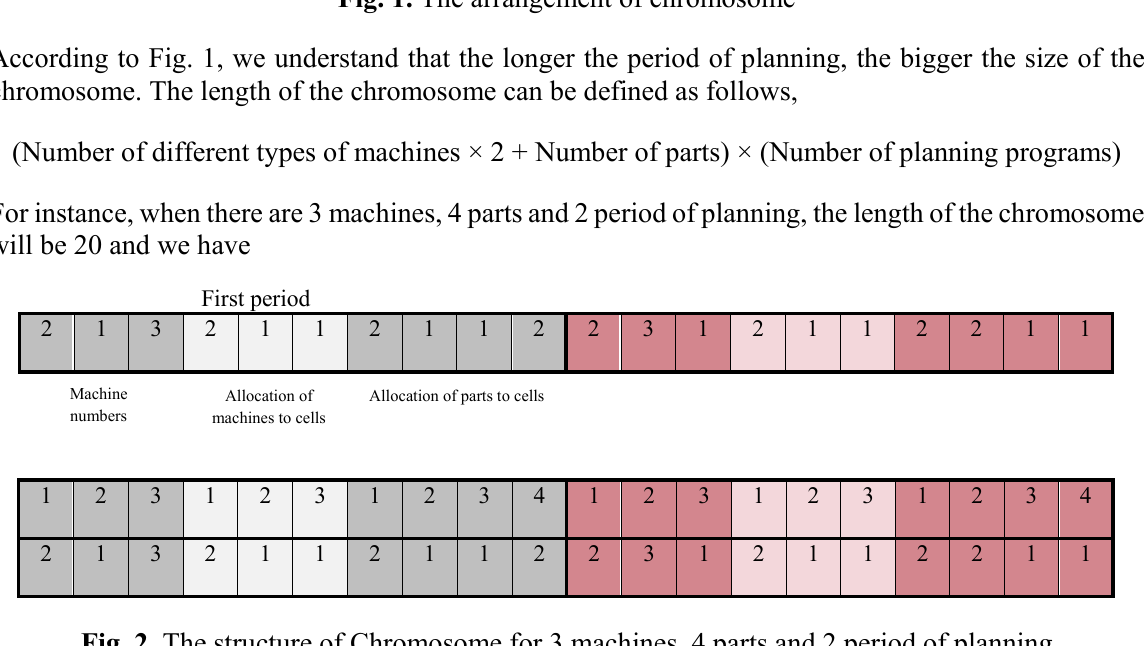
Fig. 2. The structure of Chromosome for 3 machines, 4 parts and 2 period of